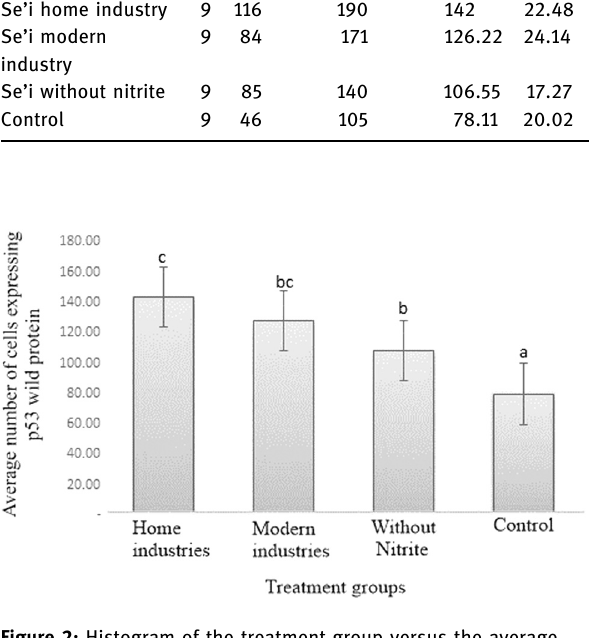
Table 2: Descriptive analysis of expressions of wild - type p53 protein Groups